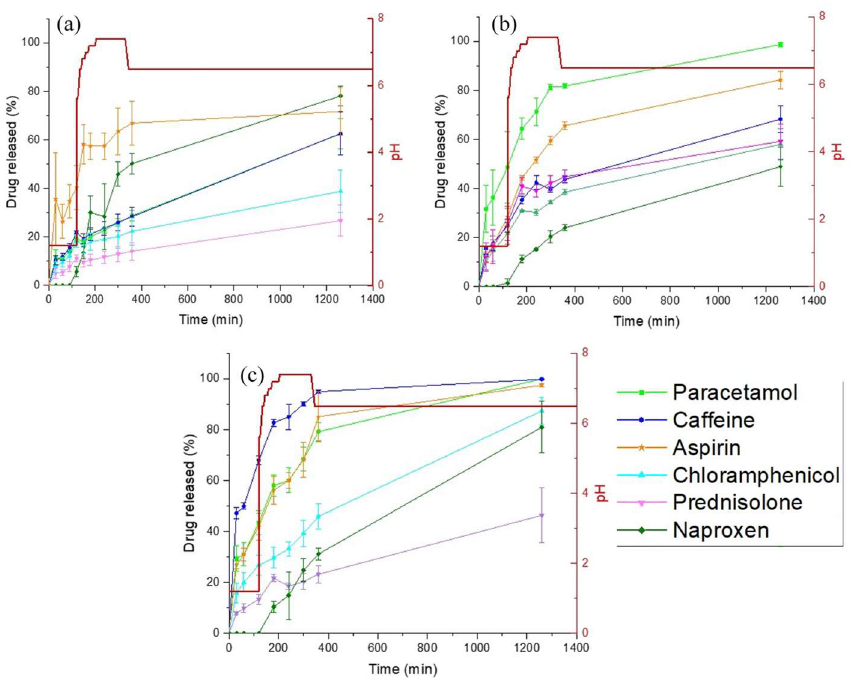
Figure 7. Drug dissolution profiles for the 3D printed polypills: ( a ) Type 1 cylindrical polypill; ( b ) Type II ring-shaped polypill; and ( c ) Type III ring-shaped polypill + PEG 300.